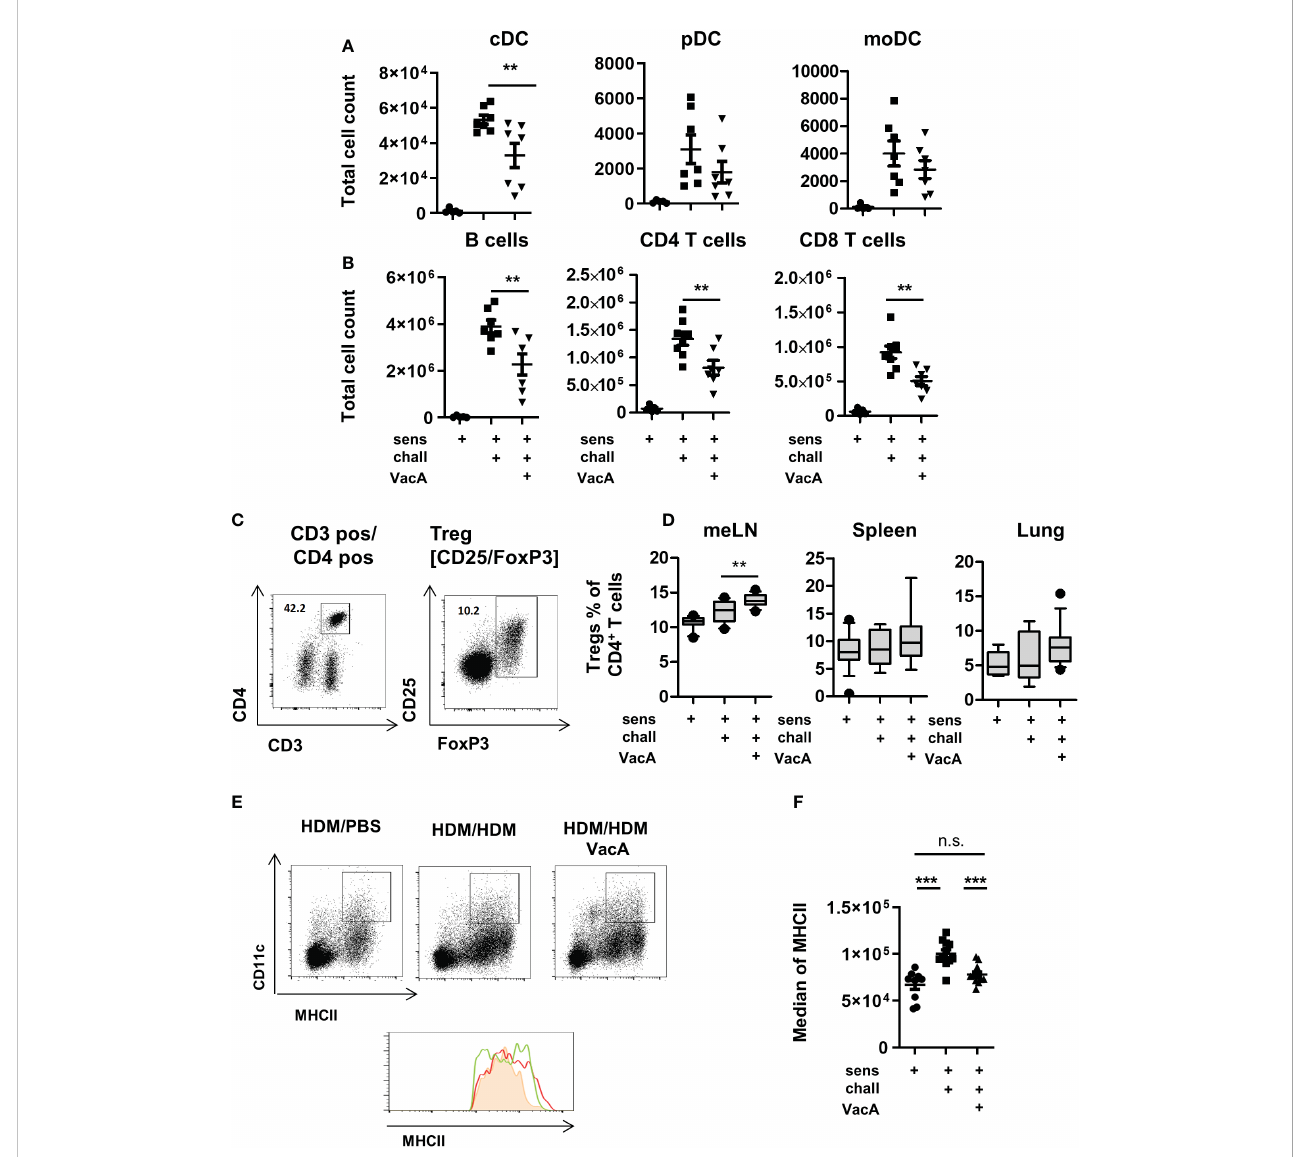
FIGURE 2 VacA treatment affects immune phenotype. Total cell counts of (A) conventional dendritic cells (cDC), plasmacytoid DC (pDC) or monocyte-derived in fl ammatory DC (moDC) and (B) B cells. CD4+ and CD8+ T cells in lung draining lymph nodes (tLN) of house dust mite (HDM)/phosphate-buffered saline (PBS), HDM/HDM and HDM/HDM VacA animals. (C, D) VacA treatment increases proportion of Tregs. (C) Tregs were characterized by the expression of FoxP3 within the population of CD3+/CD4+ T helper cells. (D) Boxplots (Whiskers 10-90 percentile) show percentage of Tregs within the population of CD4 + T cells in mesenteric lymph nodes (meLN), Spleen and tLN of HDM/PBS, HDM/HDM and HDM/HDM VacA animals. (E, F) DC in VacA-treated animals showed reduced major histocompatibility complex II (MHCII) expression in draining lymph nodes. (E) Representative dot plots show MHCII/CD11c expressing DC in draining lymph nodes of HDM/PBS, HDM/HDM and VacA-treated HDM/HDM mice. Histogram shows MHCII expression in HDM/PBS (shaded orange), HDM/HDM (red line) and HDM/HDM VacA animals (green line). (F) Graph shows median MHCII expression on DC in the draining lymph nodes of HDM/PBS, HDM/HDM and HDM/HDM VacA-treated mice. Each point represents one animal. (A, B) results from two independent experiments, n=5 – 7 per group. (C, D) results from 3 – 5 independent experiments, n=10 – 21 per group. (E, F) results from three independent experiments, n=9 – 12 per group. Analysis of variance: *p<0.05, **p<0.01,